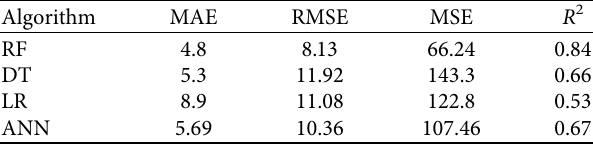
Table 4: Results of the study.